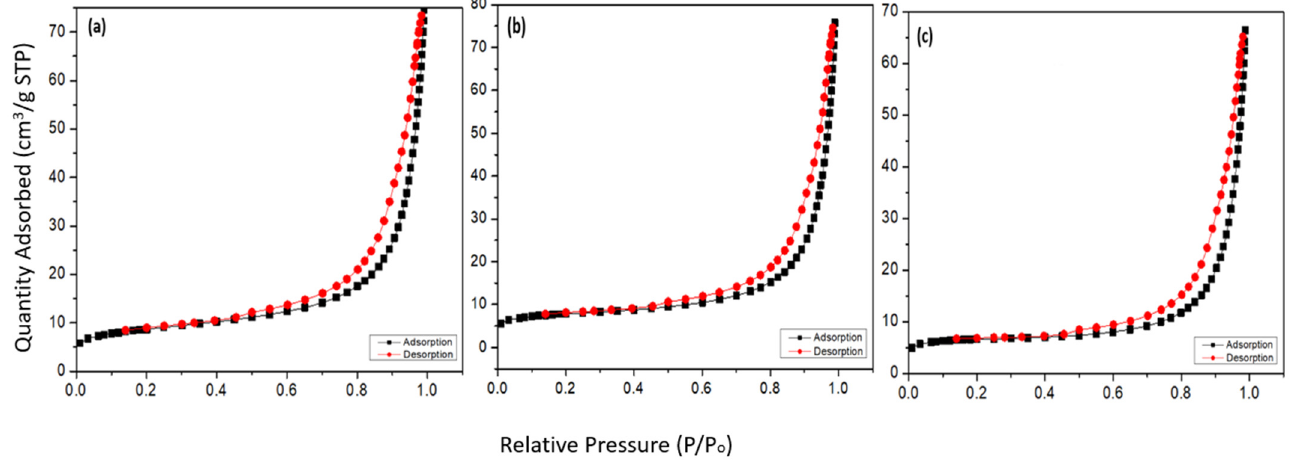
Figure 5. The nitrogen adsorption/desorption isotherms of ( a ) NZ, ( b ) PZ, and ( c ) SZ.